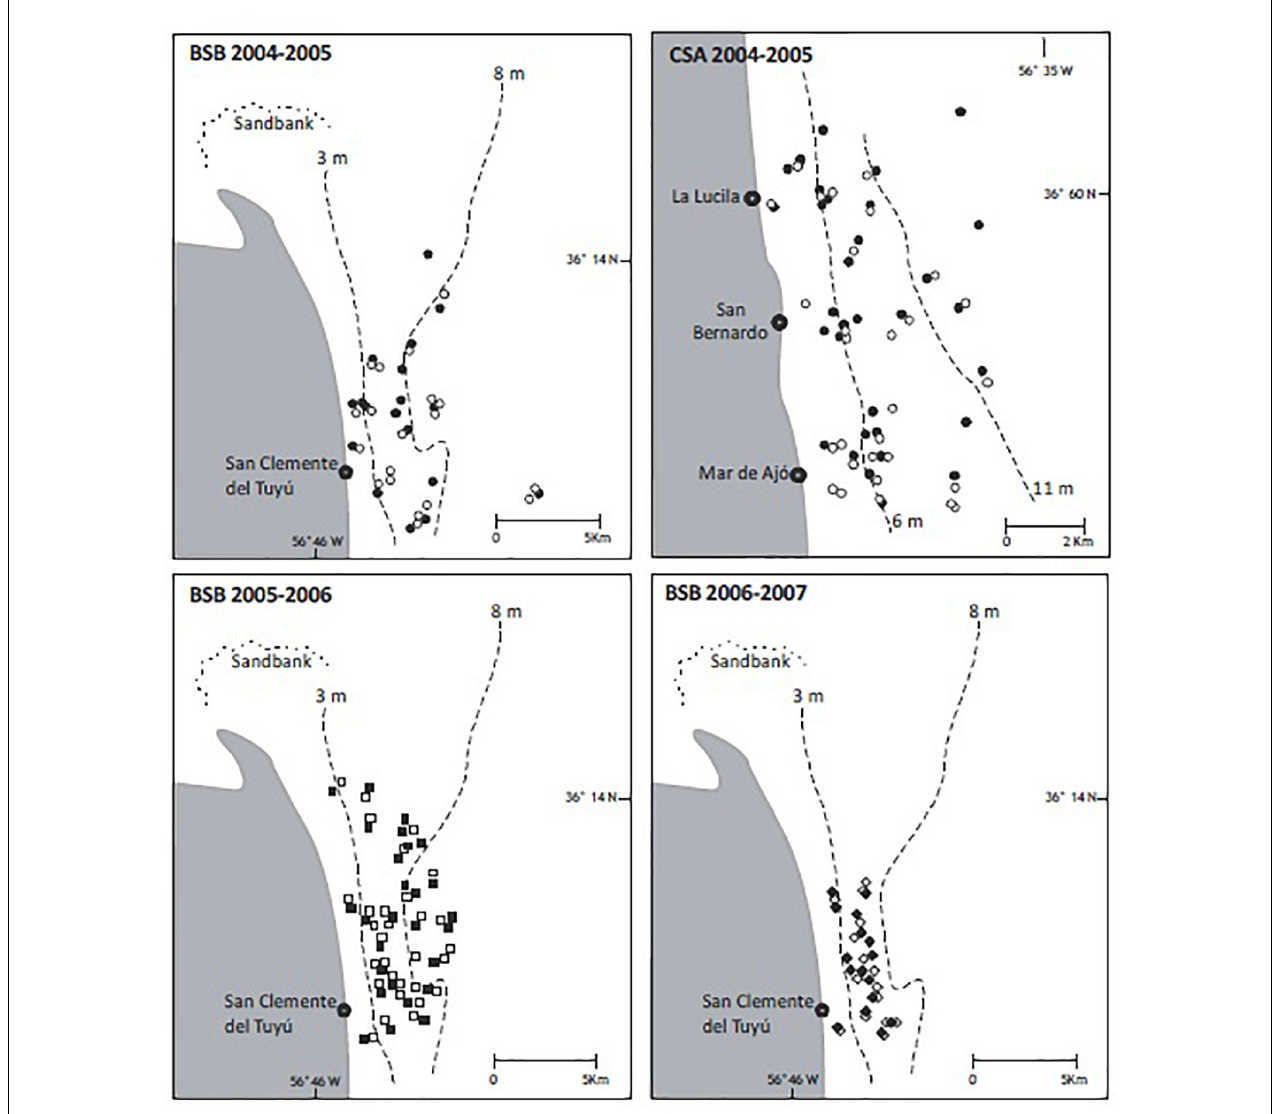
FIGURE 3 | Location of gillnets (black) and experimental bottom longlines (white) hauls in Bahía Samborombón (BSB) and Cabo San Antonio (CSA).